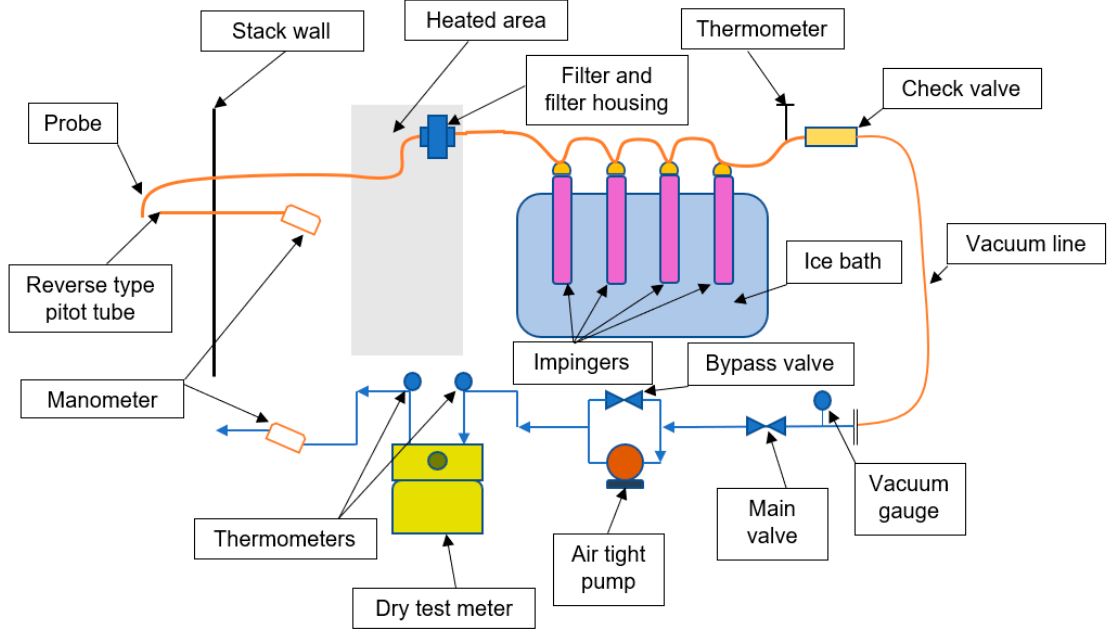
Figure 2. Typical isokinetic sampling equipment schematic [26].